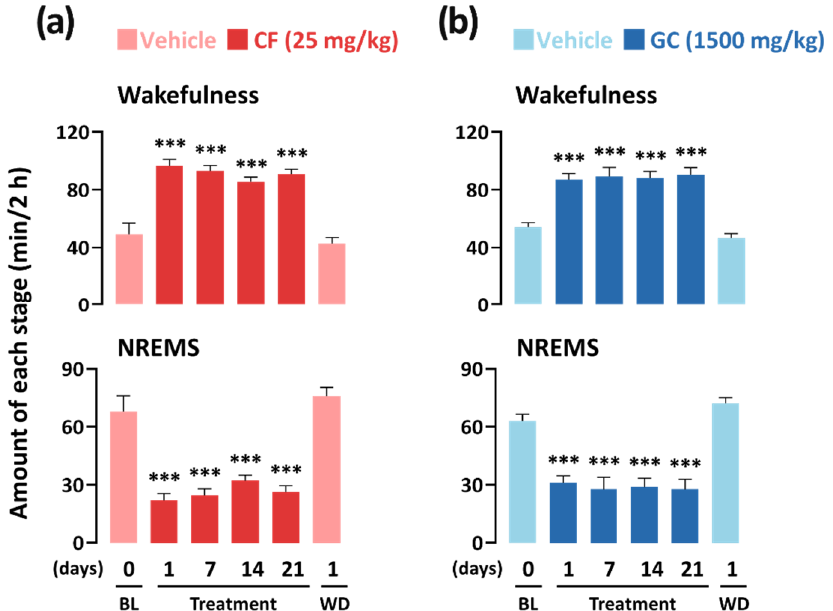
Figure 6. Chronic (3 weeks) administration effects of caffeine ( a ) and GC ( b ) on wakefulness and NREMS in C57BL/6N mice over a period of 2 h after administration. Light color bars indicate the baseline (BL, vehicle) or withdrawal (WD) day. Each value represents the mean ± SEM of each group. ( n = 7–8). *** p < 0.001, significantly different from vehicle (unpaired Student’s t -test). CF, caffeine; GC, G . cambogia peel extract; NREMS, non-REMS; Wake, wakefulness; SEM, standard error of mean.